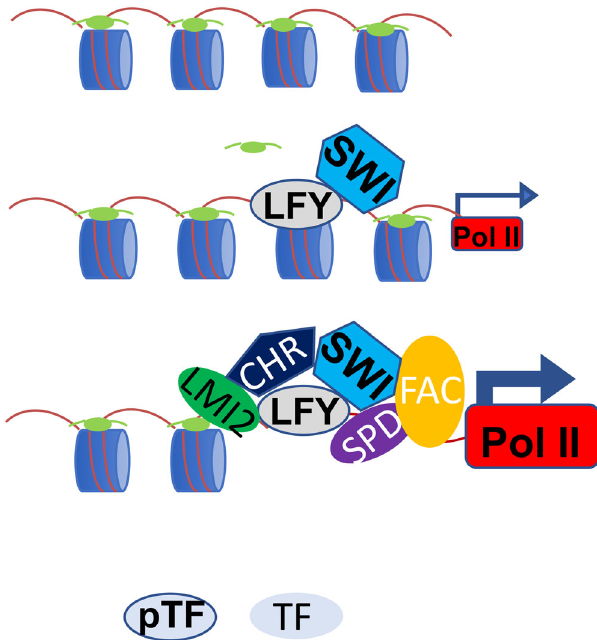
Fig. 8 Hierarchical model for root explant reprogramming to fl oral fate by the LFY pioneer transcription factor. LFY binds to a nucleosome occupied target site and locally opens chromatin by displacing H1 linker histones (light green ellipse) and by recruiting SWI/SNF chromatin remodelers (SWI hexagon). This leads to low initial activation of gene expression (small arrow and RNA polymerase II (Pol II)). The local chromatin unlocking enables additional transcription factors to bind the locus, these include LMI2, SPL9/DELLA (SPD) and the fl origen activation complex (FAC). See text for details. This in turn leads to recruitment of other chromatin regulators (CHR pentagon), increased gene activation (large arrow and Pol II), accumulation of the fl oral fate commitment factor AP1 and cell fate reprogramming. pTF pioneer transcription factor. TF non-pioneer transcription